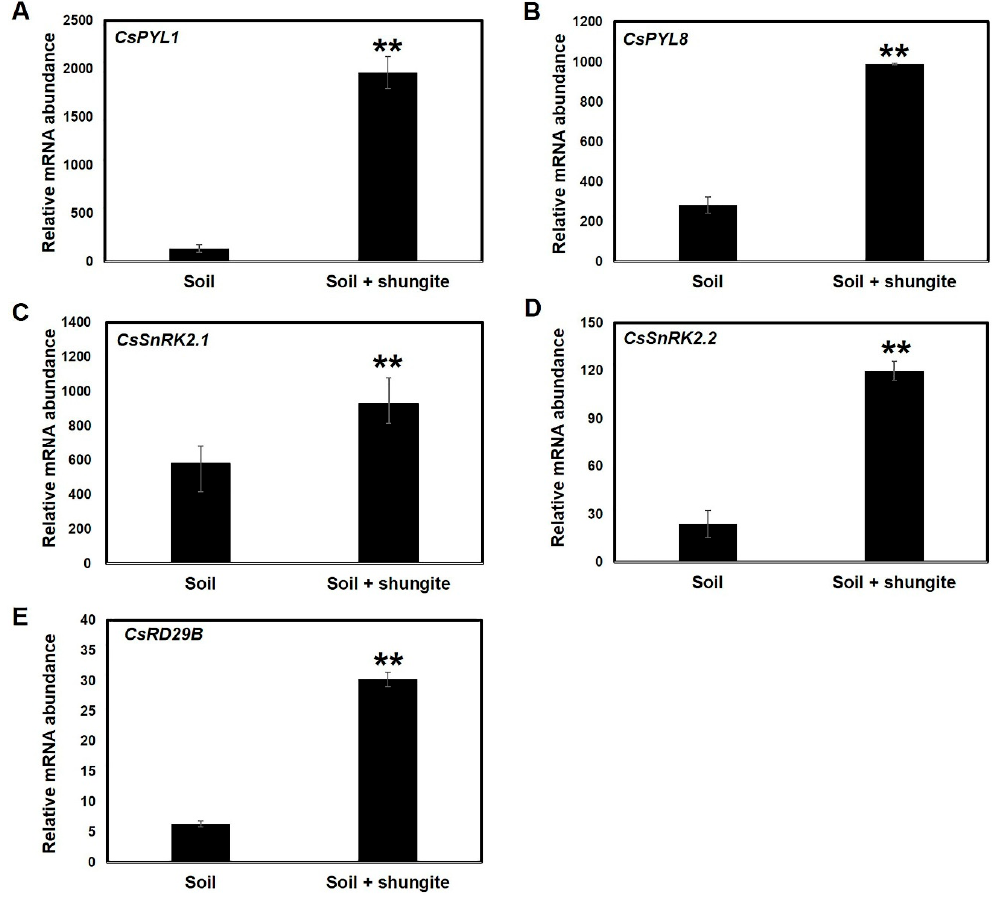
Figure 6. Expression profiling of cucumber ABA signaling genes in response to drought stress ( A – E ). Relative expression of ABA signaling transcripts was determined by real-time PCR 21 days after drought treatment. The Y-axis represents relative expression levels normalized by the elongation factor 1-aplha ( CsEF1 α ) gene ( Csa006172 ). Three independent experiments with three biological replicates were averaged (± SD). Statistically significant differences between control and shungite treatment groups at corresponding time points are indicated by asterisks (Student’s t-test, ** P ≤ 0.05).